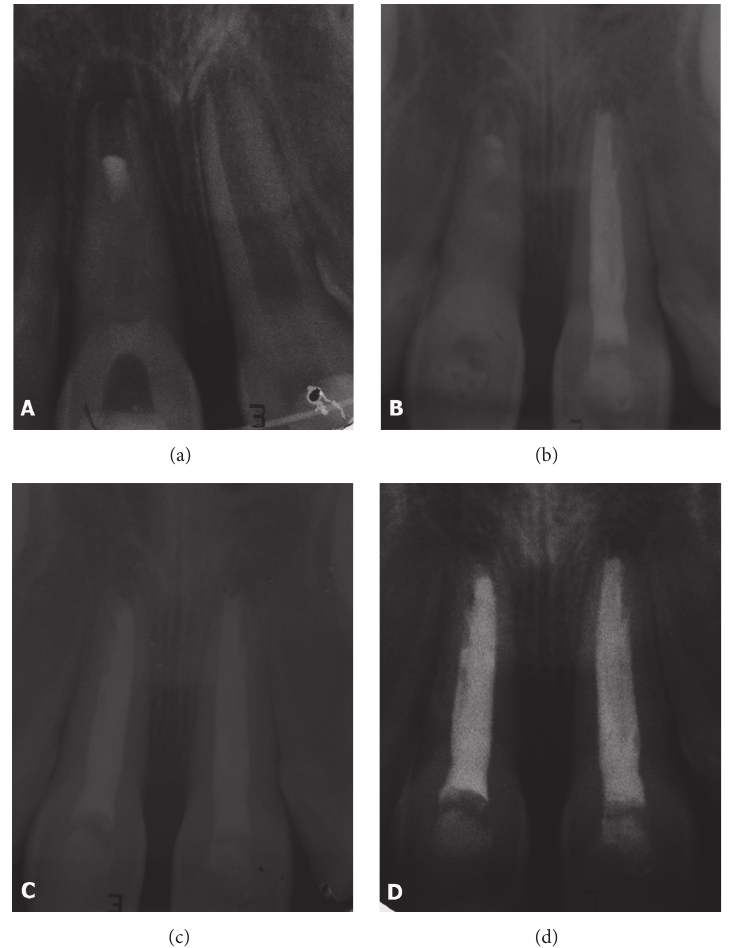
Figure 1: (a) Initial radiograph after tooth replantation (tooth 11), evidencing the incomplete root formation, the MTA apical plug about 2 mm inside of root canal, and the intracanal medication with calcium hydroxide-based paste. (b) Radiographic examination after 2 months, revealing apical closure and slight increase in root length of the replanted tooth (tooth 11). Endodontic treatment was performed on the left central incisor (tooth 21). (c) Radiographic examination 6 months after treatment of tooth 11, revealing apical closure. (d) Final radiographic examination, after a follow-up of 1 year and 6 months, revealing apical closure and no sign of external root resorption of the replanted right central incisor (tooth